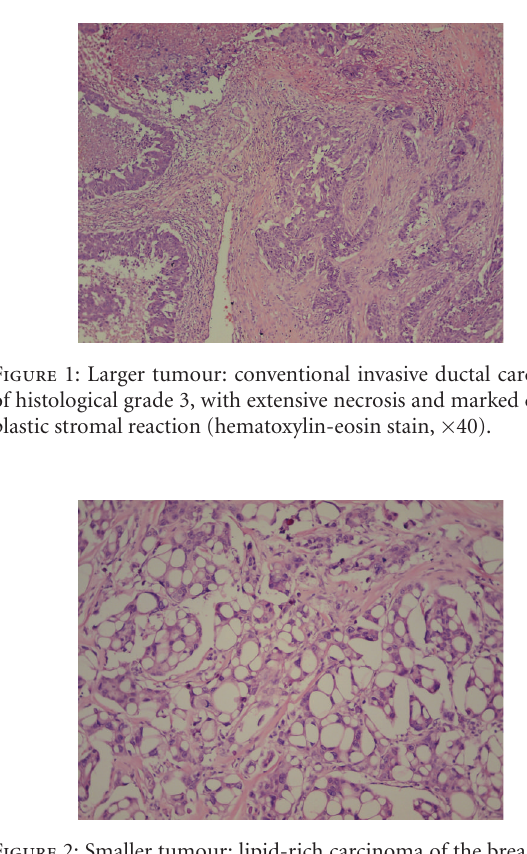
Figure 2: Smaller tumour: lipid-rich carcinoma of the breast, with atypical large vacuolated cells arranged in clusters, calcifications are seen in upper part of the picture (hematoxylin-eosin stain, ×